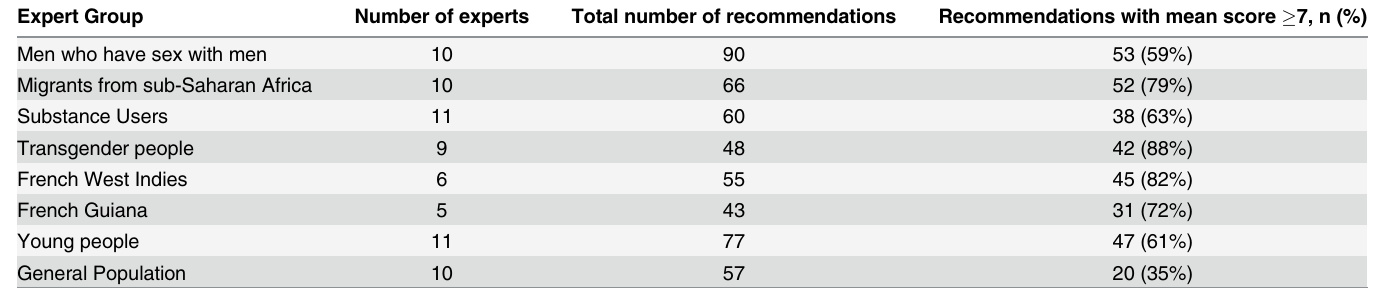
Table 3. Number of recommendations for each expert